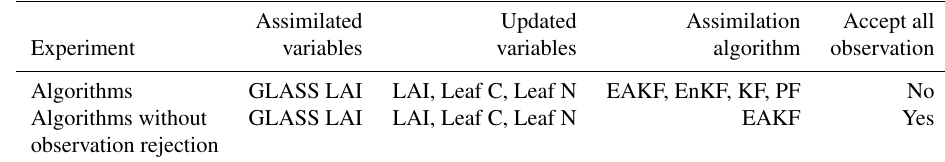
Table 1. Experimental design for LAI assimilation using DART–CLM4CN.